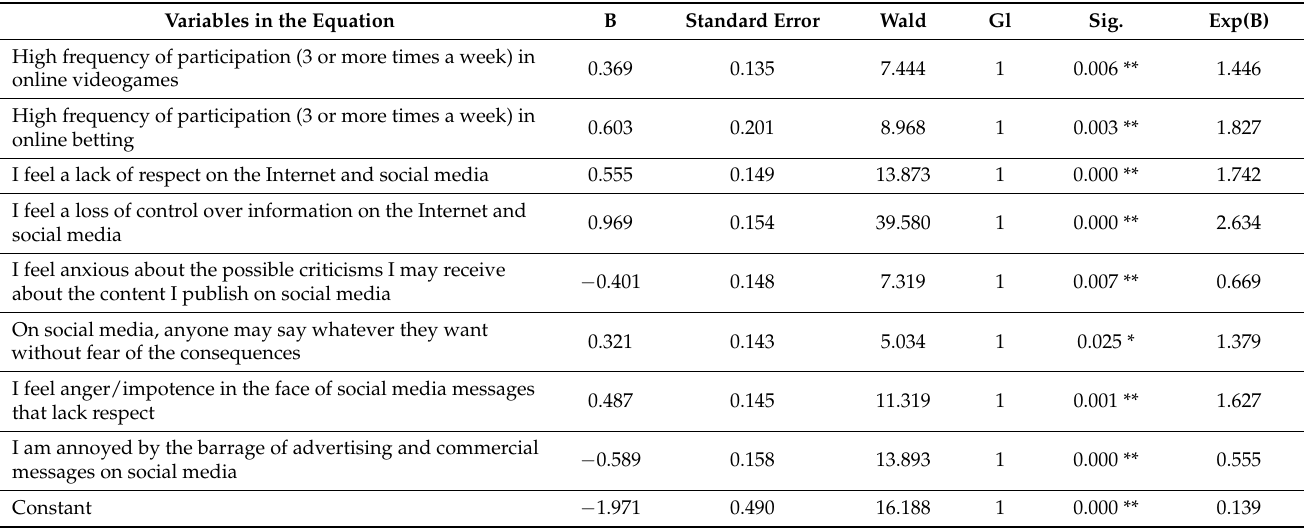
Table 6. Logistic regression model on the probability of perceiving risk or danger in abusive con- sumption of social media content.